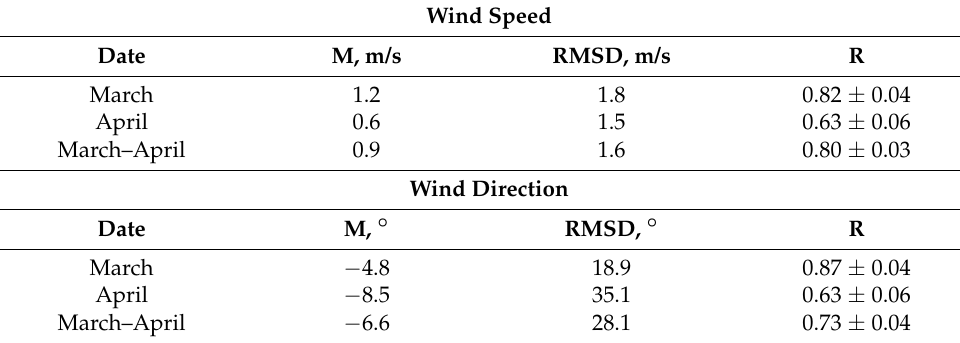
Table 3. Statistical characteristics of the wind speed and direction differences between ERA5 and WRF-Chem data for Peterhof in March and April 2019.